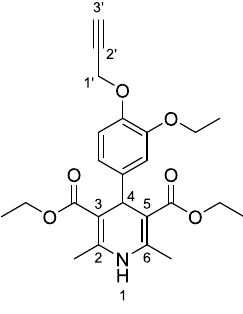
Figure 7. Chemical stucture of 3f .